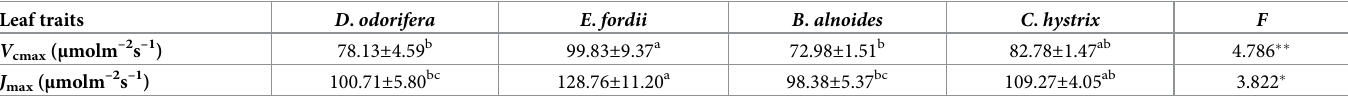
was higher than P P